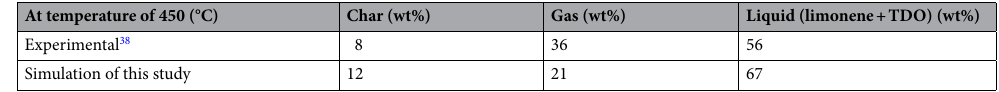
At temperature of 450